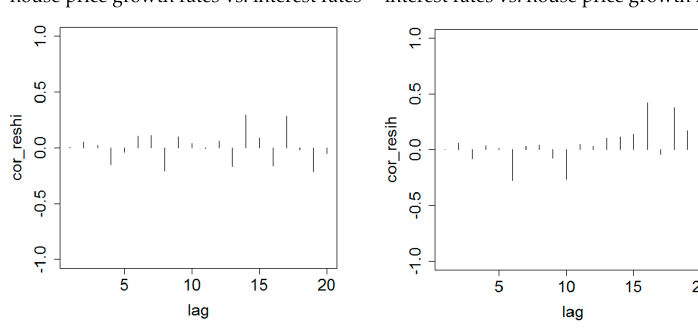
Figure 6. Sample autocorrelations and cross-correlations of residuals after fitting VAR(5).